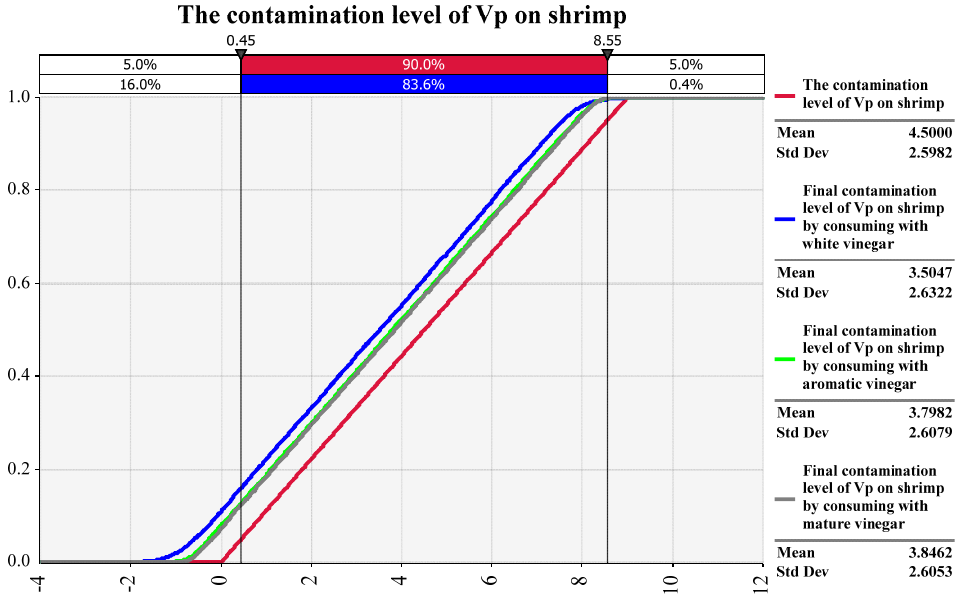
Figure 3. The final contamination level of V. parahaemolyticus on ready − to − eat shrimp by consuming without anything (Red Line), and with white vinegar (Blue Line), aromatic vinegar (Green Line) and mature vinegar (Grey Line). Note: Vp = Vibrio parahaemolyticus .